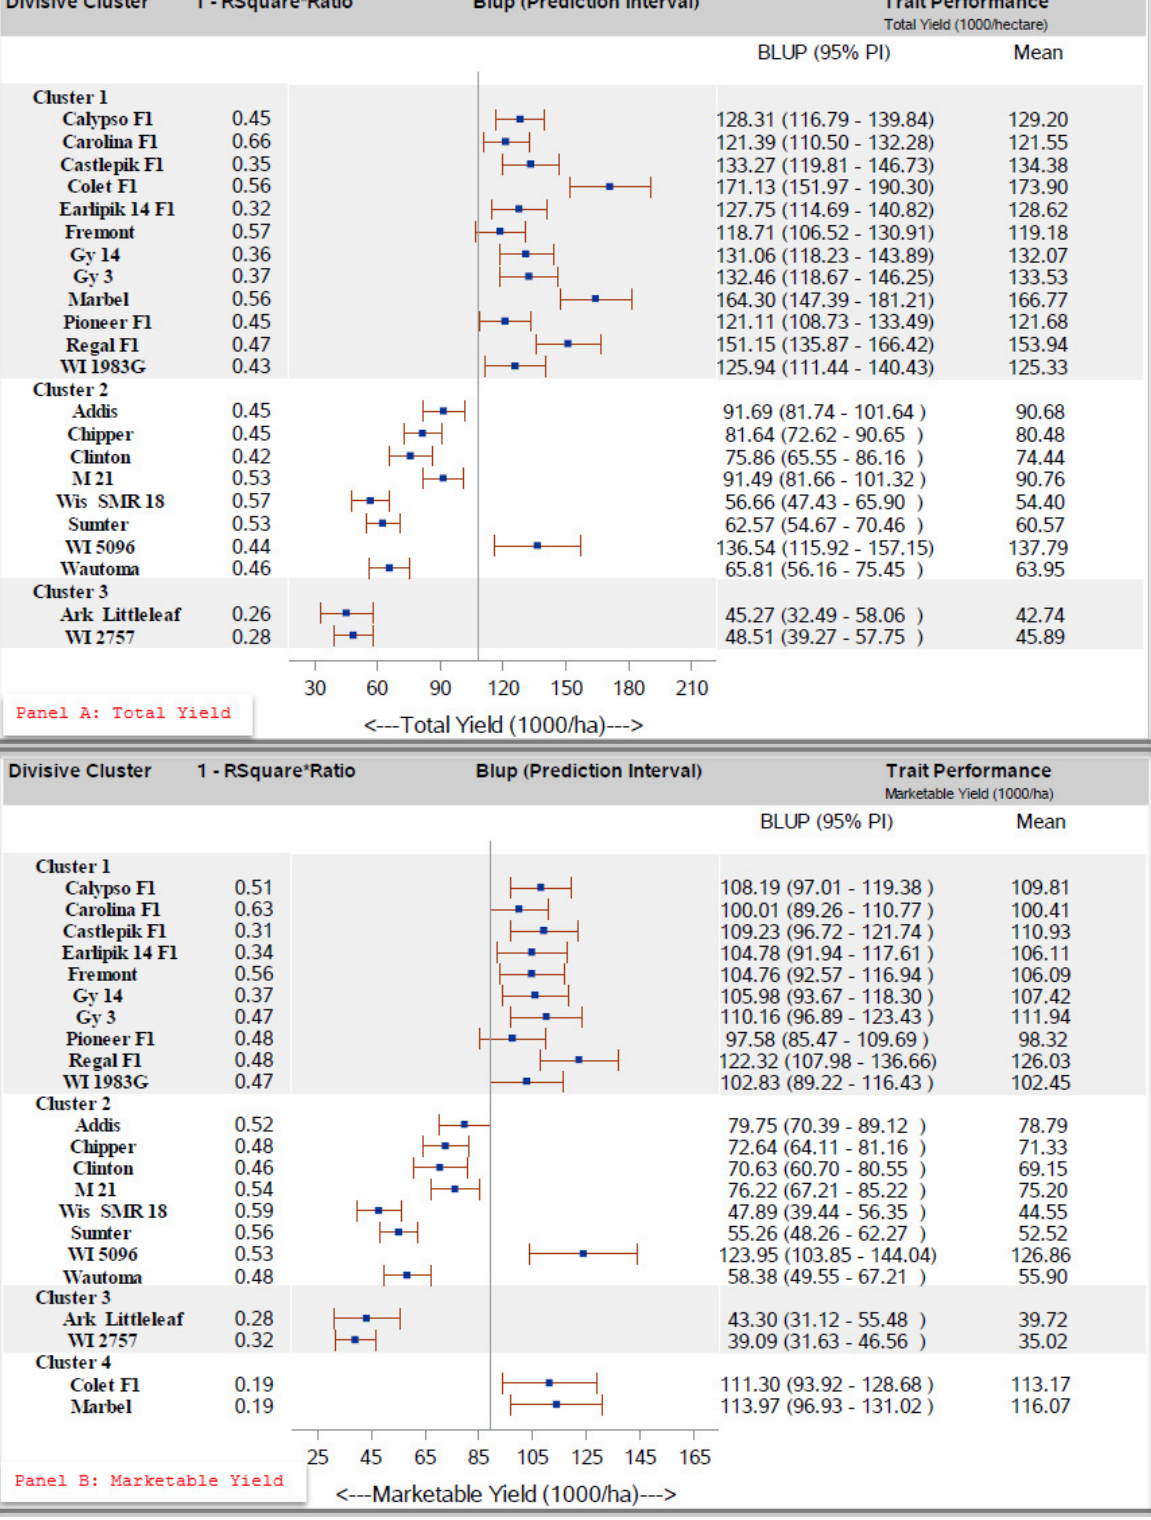
Figure 4: Divisive cluster, 1-R 2 ratio, forest plot of BLUP along with 95% prediction interval, mean, BLUP and 95% prediction interval of 22 cucumber genotypes tested in 3 years and 24 environment for total yield (Panel A) and marketable yield (Panel B). Vertical line on x-axis (horizontal scale) represent trait mean across